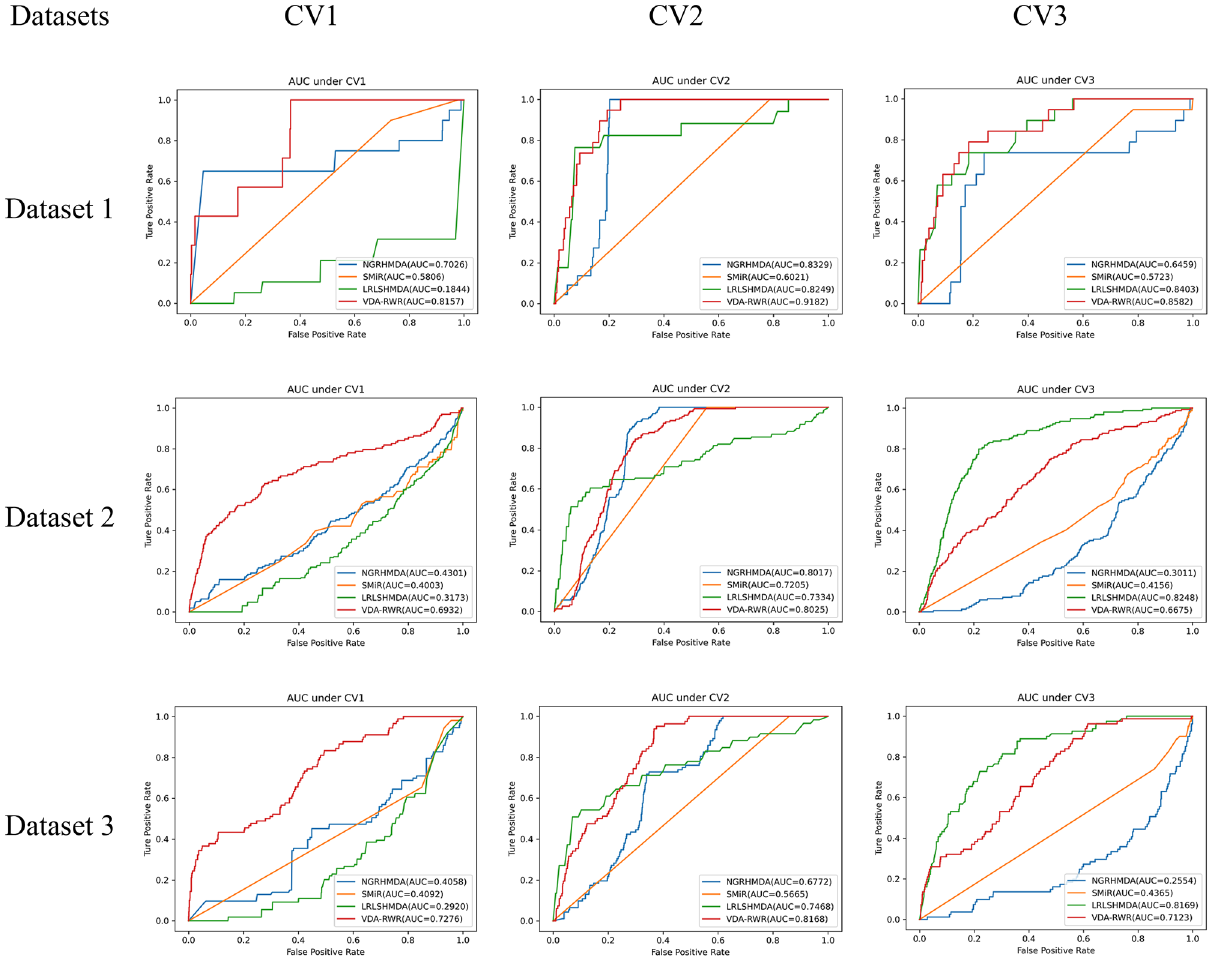
Figure 1. The AUC values of VDA-RWR under different CVs on three datasets.